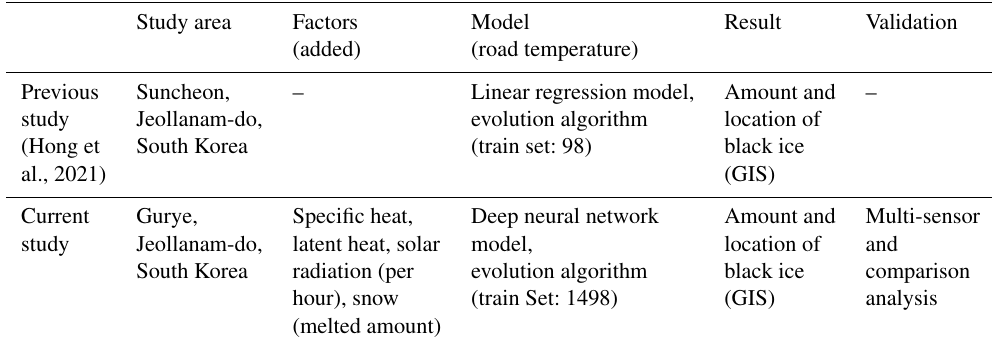
Table 1. Developments of this study compared to previous studies. Study area Factors Model Result Validation (added) (road temperature) Previous Suncheon, – Linear regression model, Amount and – study Jeollanam-do, evolution algorithm location of (Hong et South Korea (train set: 98) black ice al., 2021) (GIS) Current Gurye, Specific heat, Deep neural network Amount and Multi-sensor study Jeollanam-do, latent heat, solar model, location of and South Korea radiation (per evolution algorithm black ice comparison hour), snow (train Set: 1498) (GIS) analysis (melted